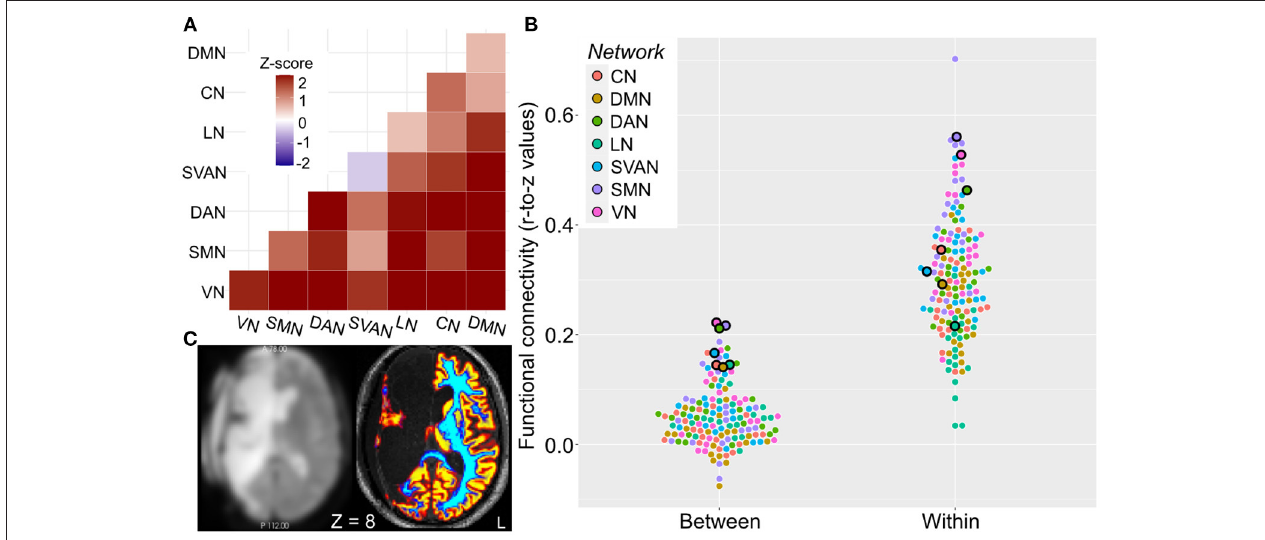
FIGURE 2 | Elevated patient resting-state functional connectivity. Network functional connectivity elevated in the case relative to healthy controls. (A) Within- (diagonal squares) and particularly between-network (off-diagonal squares) functional connectivity is elevated in the patient, as indicated by heatmap of z-scores of connectivity in patient relative to healthy controls. (B) Mean within- and “composite” between-network functional connectivity for the patient (outlined dots) and healthy controls (dots without outline). Networks are color-coded as illustrated. (C) Axial image of preprocessed BOLD fMRI (left) and high-resolution structural (right) images. Coloring indicates successful segmentation across the preserved brain areas (primarily left hemisphere); warm colors denote brain areas with high probability of gray matter, cool colors denote brain areas with high probability of white matter. Z is given in MNI coordinates. Left hemisphere is shown on right side of the figure. CN, control network; DAN, dorsal attention network; DMN, default mode network; HC, healthy controls; LN, language network; MNI, montreal national institue; SMN, somatomotor network; SVAN, salience-ventral-attention network; VN, visual